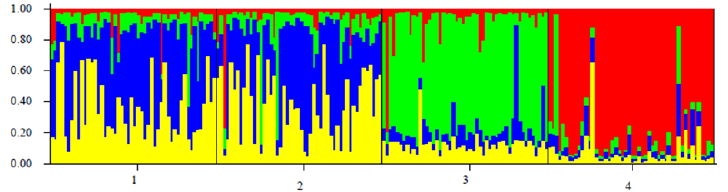
Figure 5. Graphical representation of membership of 200 individuals from AB: Arab-Barb (1); BA: Barb (2); AR: Arabian (3); and PS: En- glish Thoroughbred